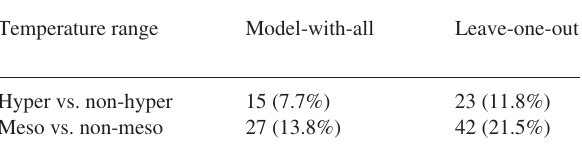
Table 4. Number of organisms misclassified using GC% to model and predict temperature optimum range. Model-with-all is the number of misclassifications when building a model using all 195 genomes. organism against a model built using the other 194 genomes.